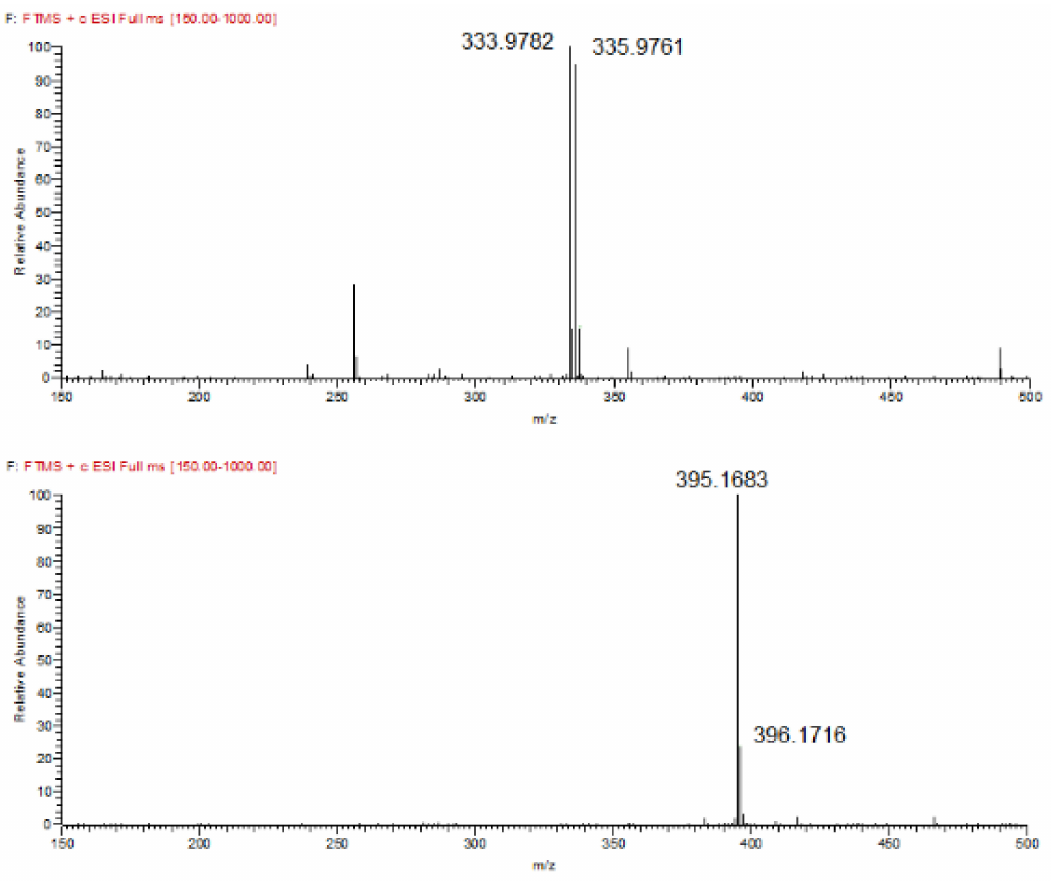
Figure 5. MS spectra showing the peaks assigned to the derivatization reagent ( top ) and derivatized pregabalin ( bottom